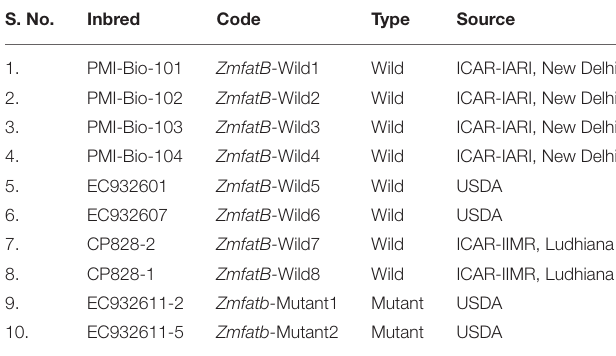
TABLE 1 | Details of diverse maize inbreds used in the study for characterisation of fatb gene. S.